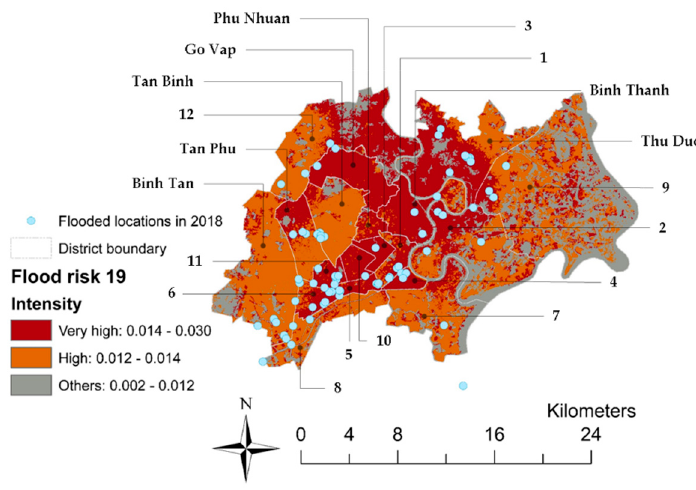
Figure 6. The spatial distribution of actual flooded locations in